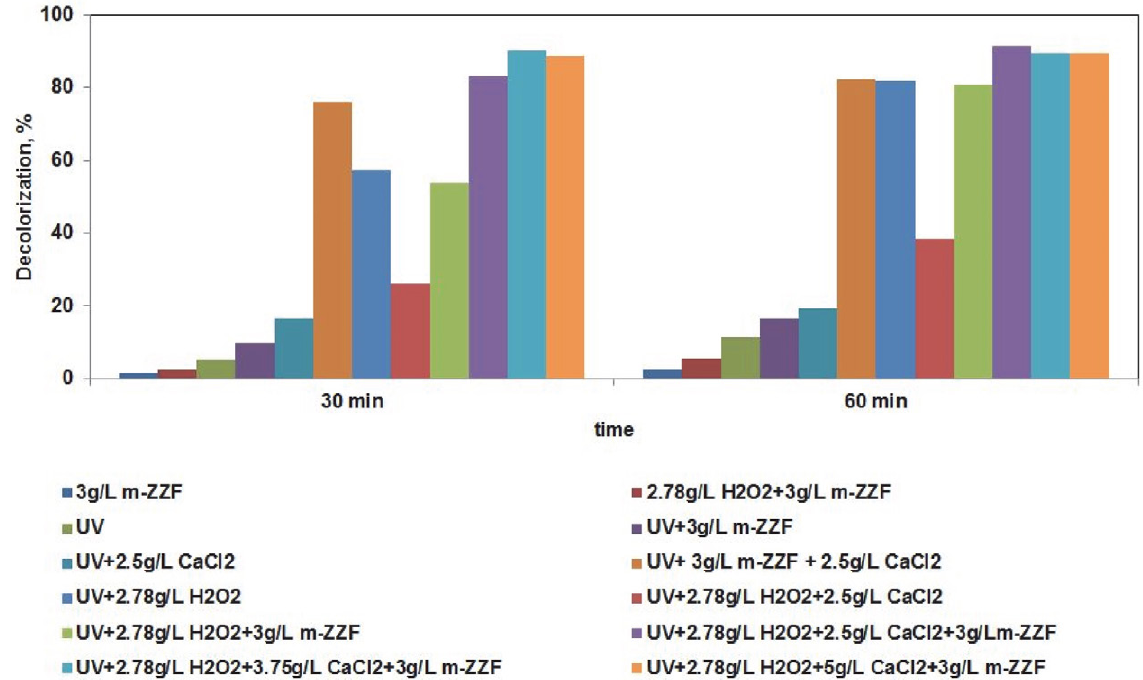
Fig. 9. Comparison of different